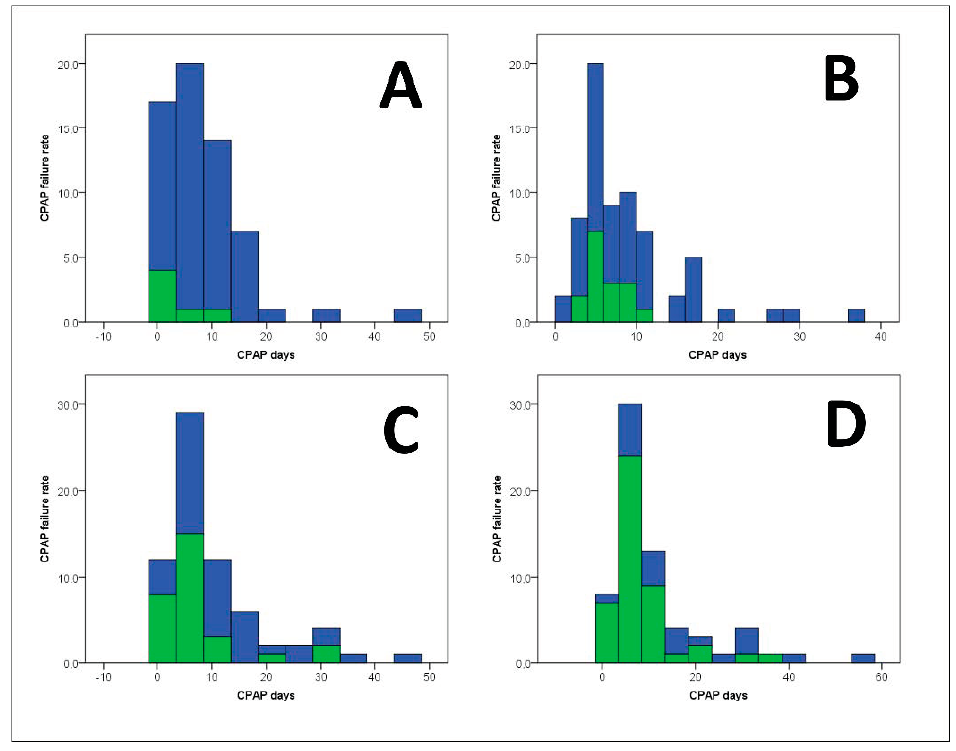
Figure 2. Distribution of CPAP failures in the different sub-classes of CPAP Failure Score. ( A ) First quartile; ( B ) second quartile; ( C ) third quartile; ( D ) fourth quartile. Green = failure; blue = no failure.